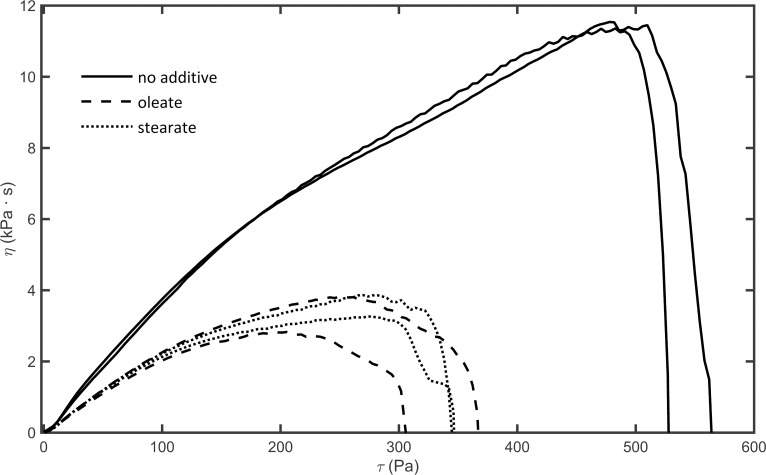
Effect of free fatty acids on the gel/fluid transition of fibrin clots.Fibrin clots were prepared in the measurement gap of a cone-and-plate type oscillation rheometer as detailed in Materials and methods. Thereafter, stepwise increasing shear stress (τ) was applied to the clot and dynamic viscosity (η) was determined. The abrupt fall in viscosity to 0 indicates the gel/fluid transition of the fibrin clots (τflow in Table 2). Two representative curves are shown for each clot type.